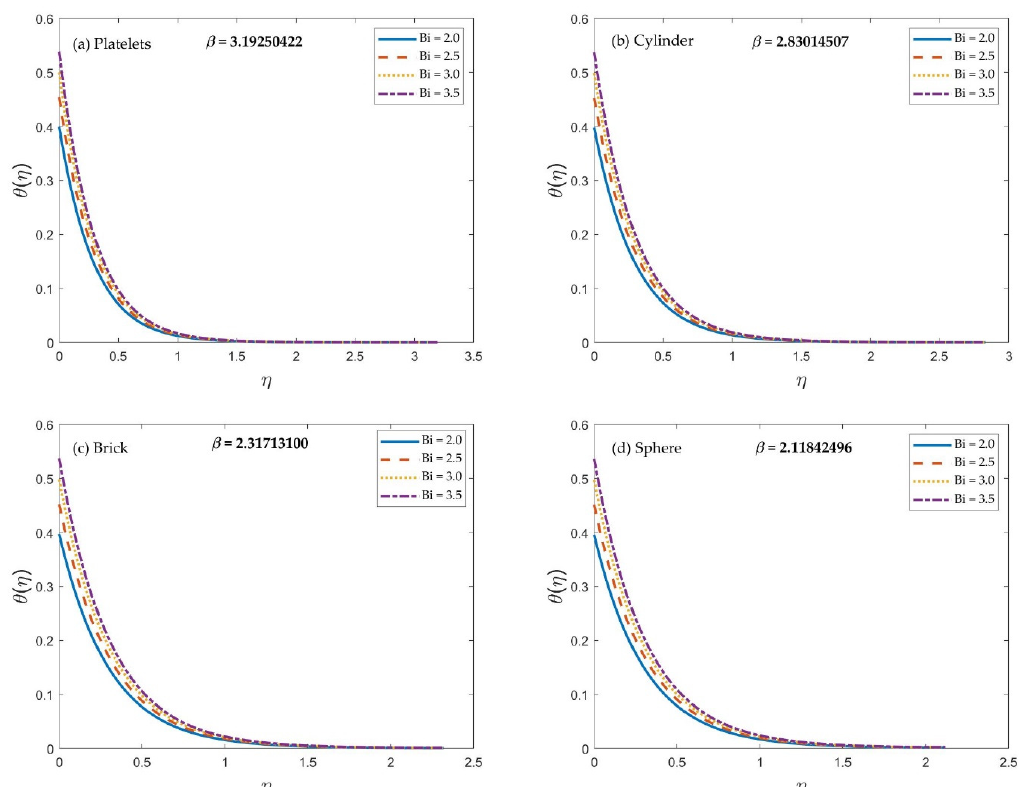
Figure 7. Impact of the Biot number Bi on the temperature profile for S = 0.4, K = 0.5, ϕ = 0.02, M = 1.0, λ = − 2.0, α = π /4 and Pr = 8.0.